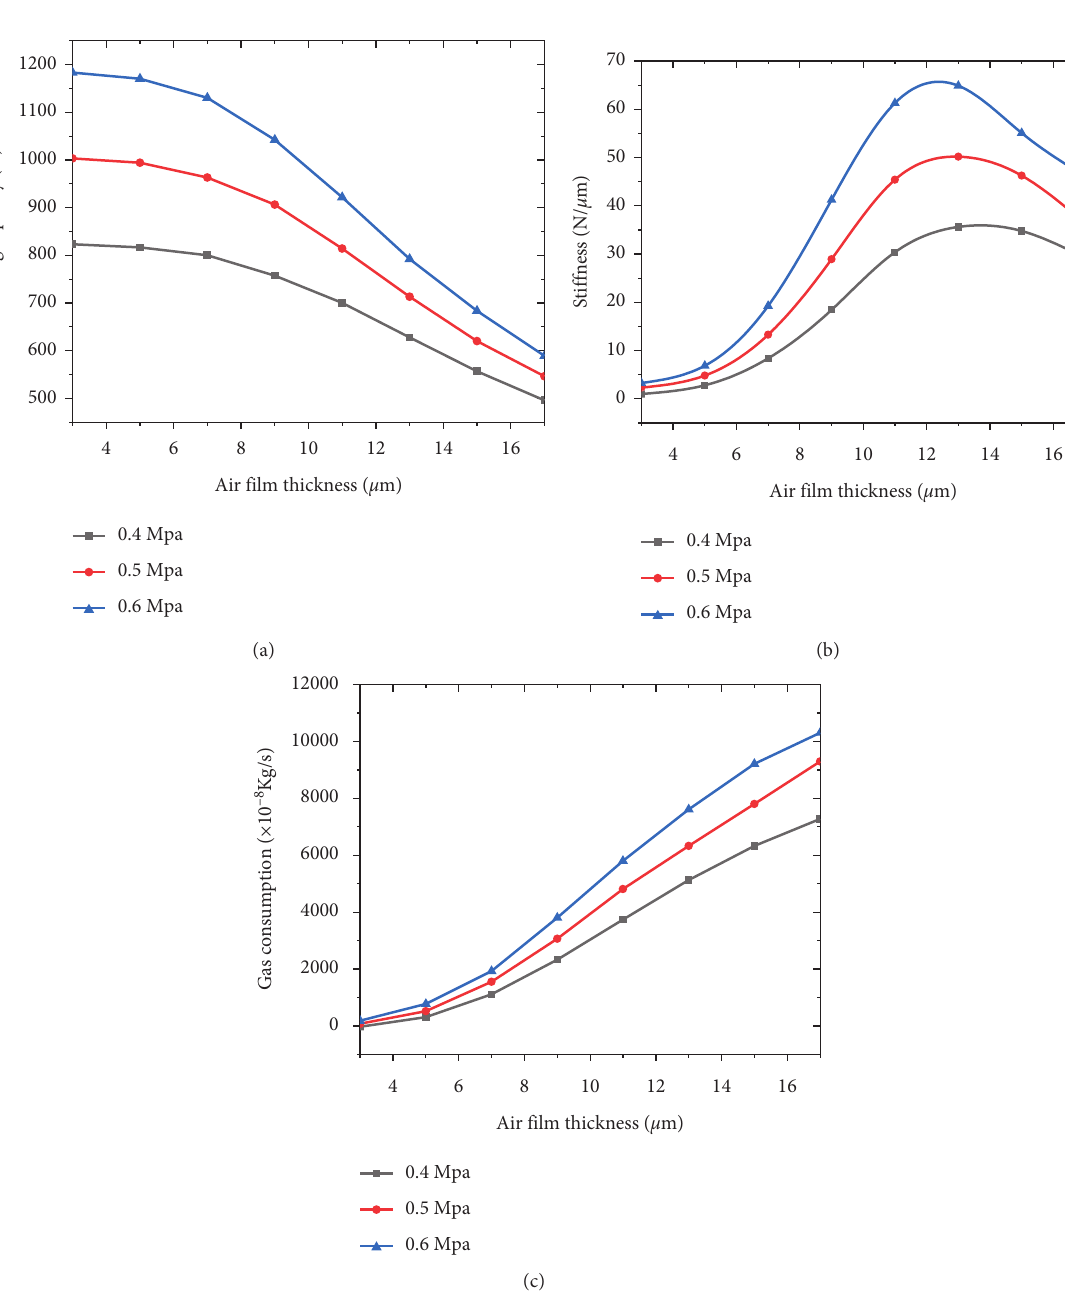
Figure 10: Effect of air supply pressure on bearing air consumption.